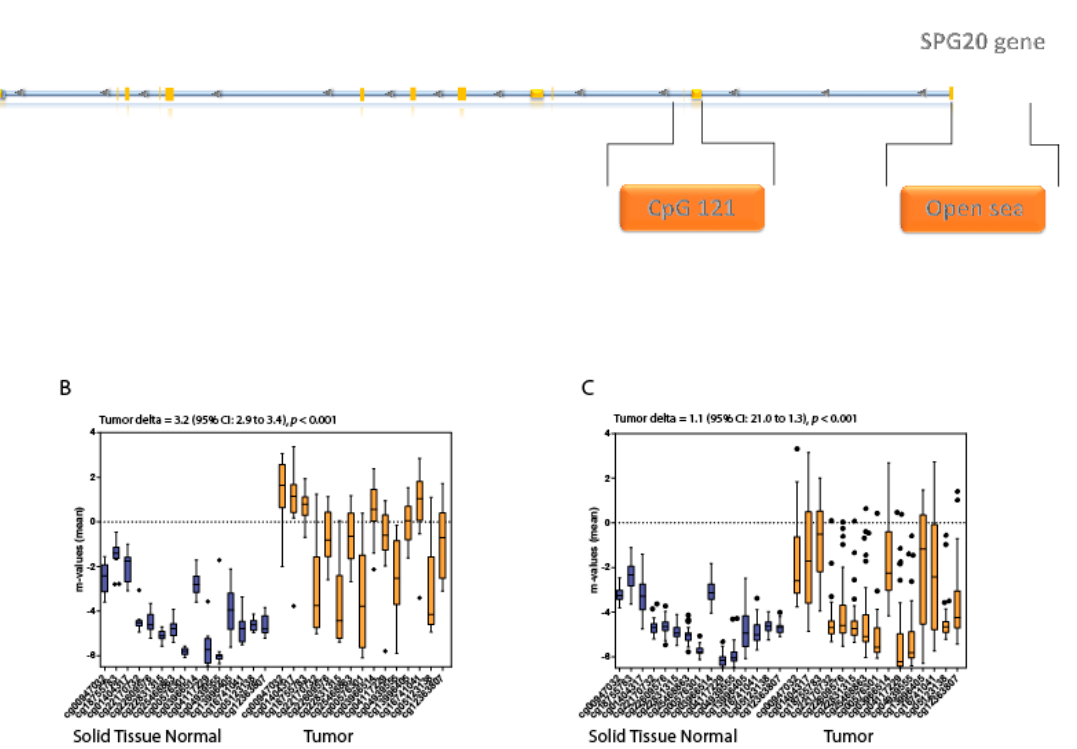
Figure 5. ( A ) Schematic representation of the SPG20 gene with the localization of the two